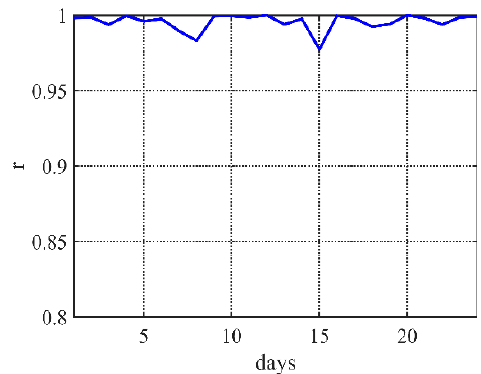
Figure 5. The error of several days.